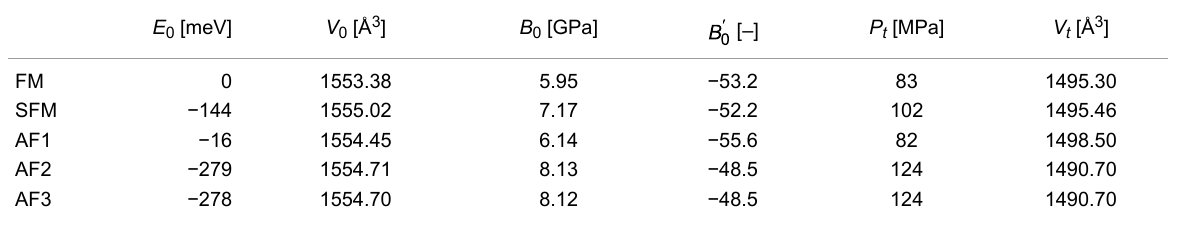
Table 1: Equilibrium structure parameters obtained from a 9-point fit to the Rose–Vinet equation of state with volumes ranging over ±4% with regard to the equilibrium volume: the ground state energy of the magnetic configuration relative to the ferromagnetic configuration ( E 0 ), the equilibrium volume ( V 0 ), the bulk modulus ( B 0 ) and its pressure derivative ( ). The root-mean-square deviation (rmsd) for each of the five fits is less than 0.8 meV. In addition, also the transition pressure P t and volume V t for which a large-pore MIL-47(V) is expected to transform into a narrow-pore struc- ture is given.